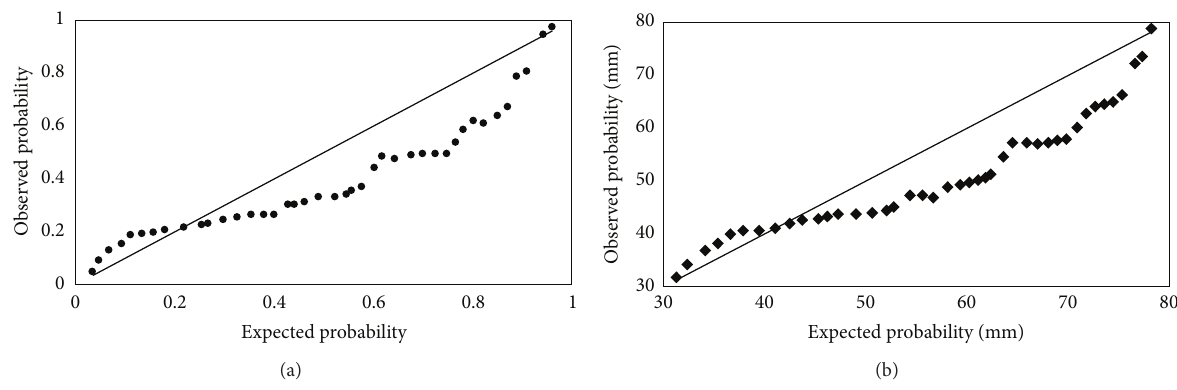
Figure 4: (a) Probability plot; (b) quantile-quantile plot for Xinjiang, Model